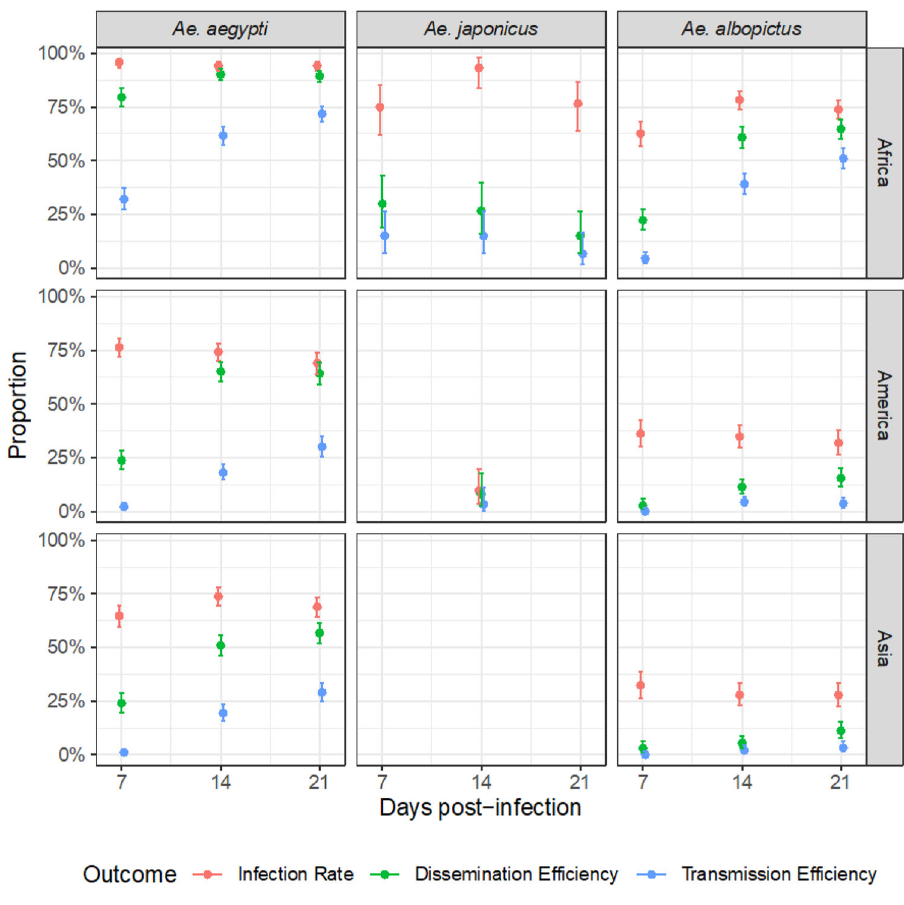
Fig. 1 | Infection rate, dissemination and transmission ef fi ciencies of ZIKV strains (Africa, America, Asia) according to time since infection in three Aedes mosquito species. Panels show the rates achieved by averaging over all sampled mosquitoes, i.e., by pooling together mosquitoes from all countries used in the study. Error bars are exact 95% binomial con fi dence intervals centered on the